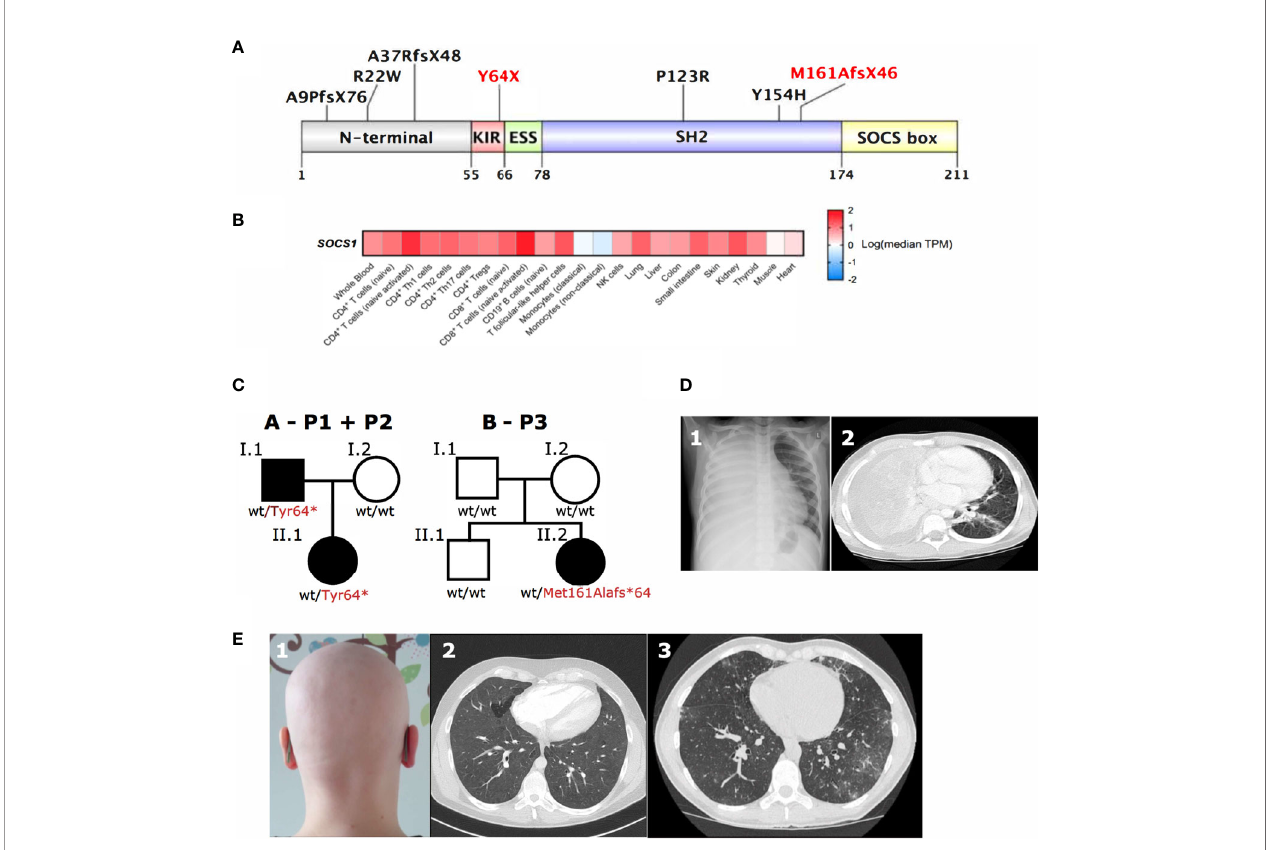
FIGURE 2 | SOCS1 tissue expression, genetic and clinical pleiotropy. (A) Schematic of SOCS1 protein showing locations of pathogenic mutations described. Mutations further investigated here highlighted in red. KIR, Kinase inhibitory region; ESS, Extended SH2 subdomain; SH2, SH2 domain; SOCS box, SOCS box domain (Uniprot O15524). (B) Heatmap of SOCS1 expression across immune cells and tissues. TPM, transcripts per million. (C) Family trees of two SOCS1 +/- kindreds with a total of three affected individuals. (D) 1 Chest radiography and 2 computed tomography (CT) scan showing dense consolidation of the entire right lung fi eld with associated empyema due to bacterial infection in P1 with SOCS1 +/- . (E) 1 Autoimmune alopecia totalis in the same patient (P1) as well as 2 CT scans of widespread ground glass changes (P2) and 3 granulomatous lymphocytic interstitial lung disease next to bronchiectasis (P3) in two unrelated patients with SOCS1 +/- (P2,